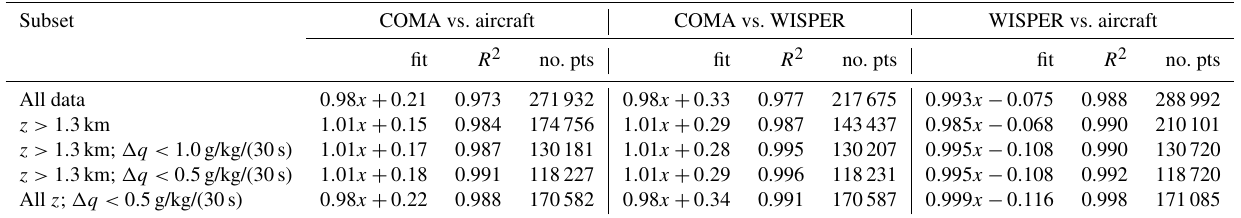
Table 2. Correlations between measures of water vapor for ORACLES 2016, 1s data resolution, for the subsets shown in Fig. 2. All correlations are significant at the p < 0 . 001 level; the statistical significance and the slopes of the correlations are largely similar for each subset. Subset COMA vs. aircraft COMA vs. WISPER WISPER vs.